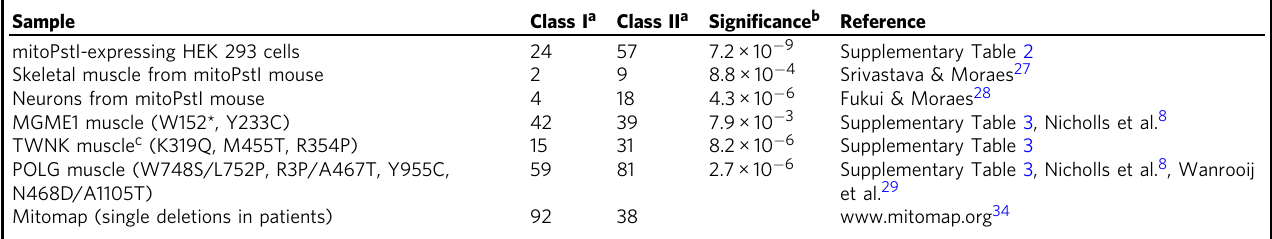
Table 1 Low proportions of breakpoints with fl anking direct repeats in mitoPstI-expressing cells and de fi ciencies of MGME1, POLG and TWNK